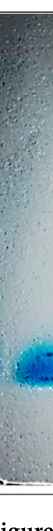
Figure 1. SDS-PAGE of EAH showing the two isoforms of EAH obtained from Aspergillus niger GH1.